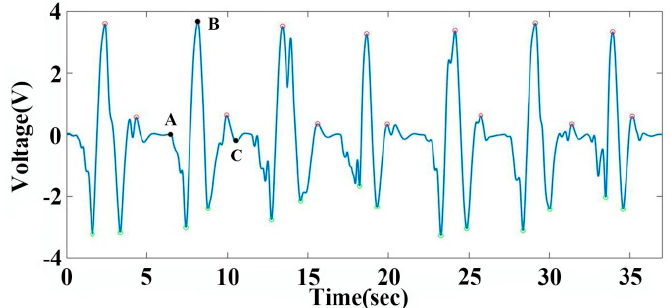
Figure 6. Signal acquired by graphene sensor for monitoring deep respiration, A, B and C corresponding to the beginning moment of inbreath, starting moment of expiration and beginning of a resting state, respectively.